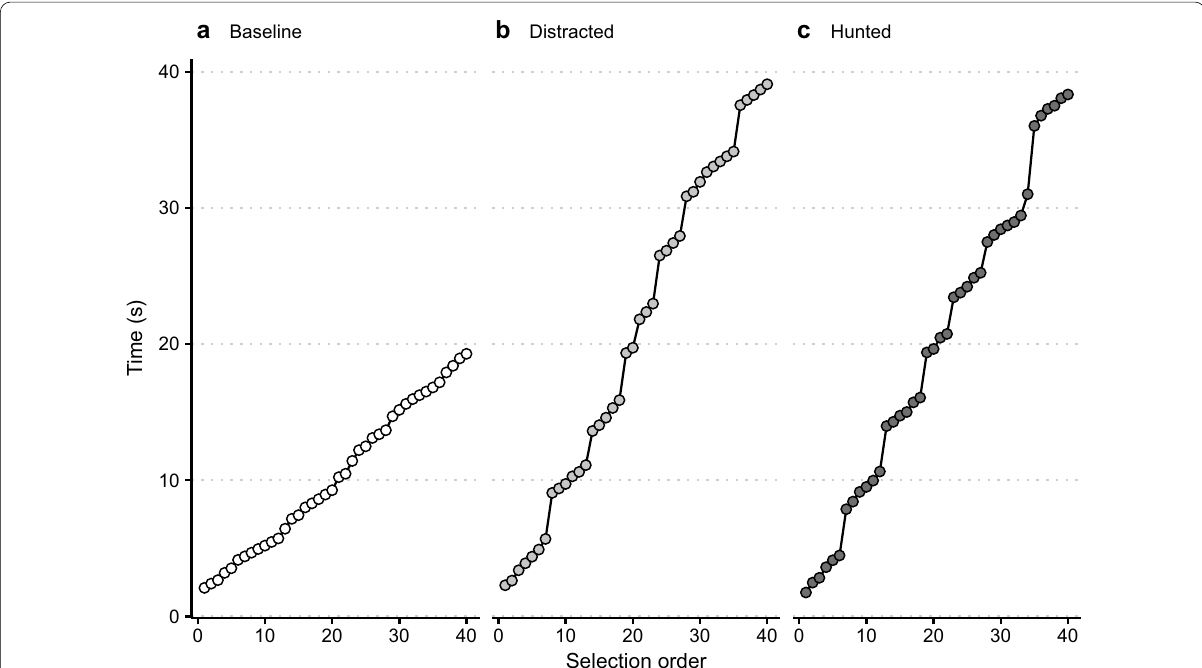
Fig. 6 The time course of three example trials, illustrating how eye-change periods affected the structure of foraging for each group of participants. The panels show a single trial from the Conjunction condition of one participant. Each dot represents a collection event, and target type is not indicated. See text for further